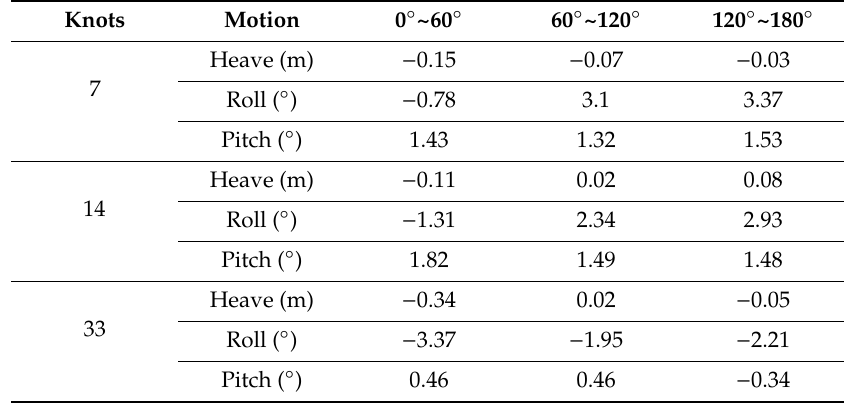
Figure 4. Comparison of results for the simulation and the on-board measurement in terms of ( a ) heaving, ( b ) rolling, and ( c ) pitching motion at medium sailing speed. Table 2. Mean deviations of the simulation data (in terms of heaving, rolling, and pitching motion) for all wave heading